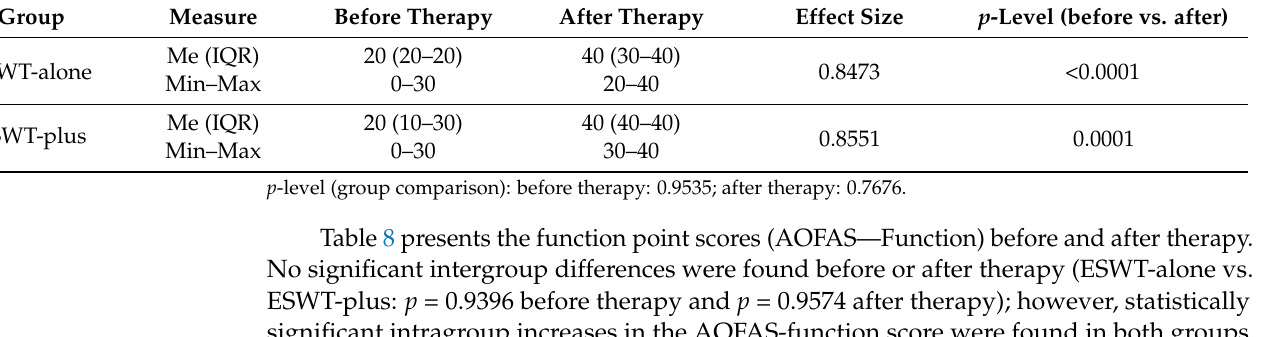
Table 7. Assessment of the AOFAS index (pain points) before and after therapy in the compared groups. Group Measure Before Therapy After Therapy Effect Size p -Level (before vs. after)